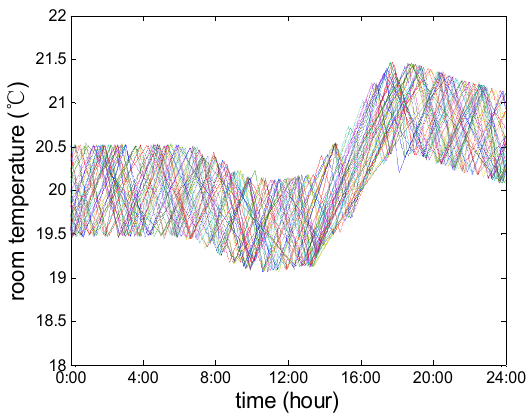
Figure 22. The variation of the indoor temperature of 30 random